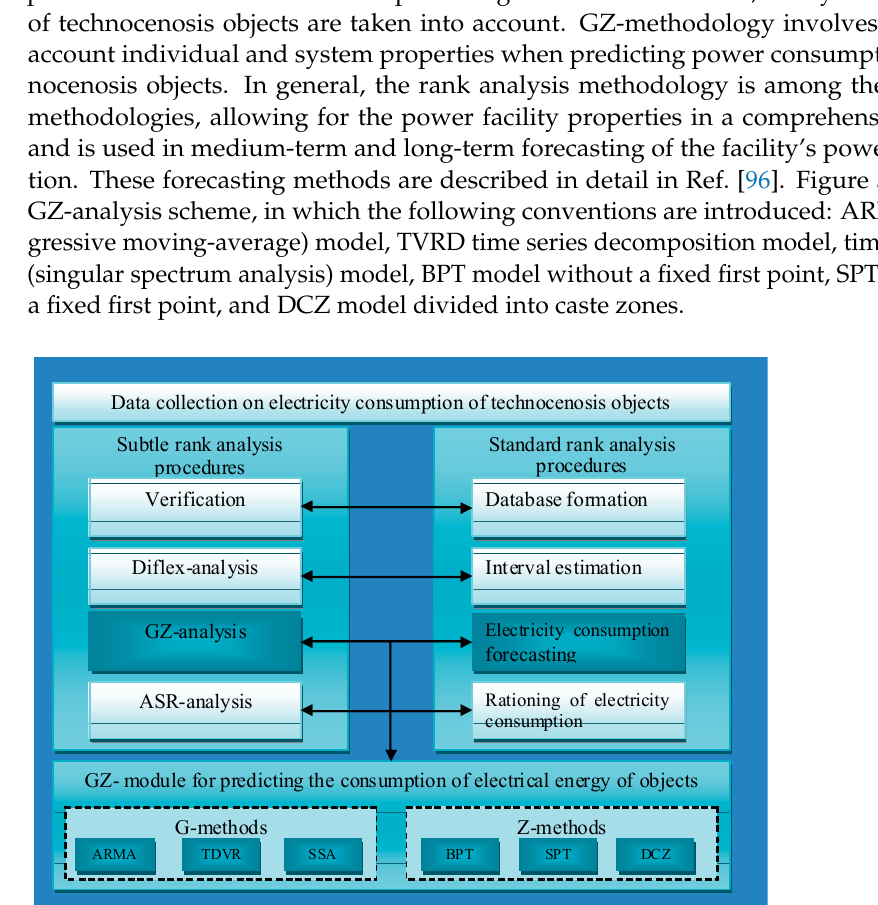
Figure 5. Standard and subtle rank analysis procedures.